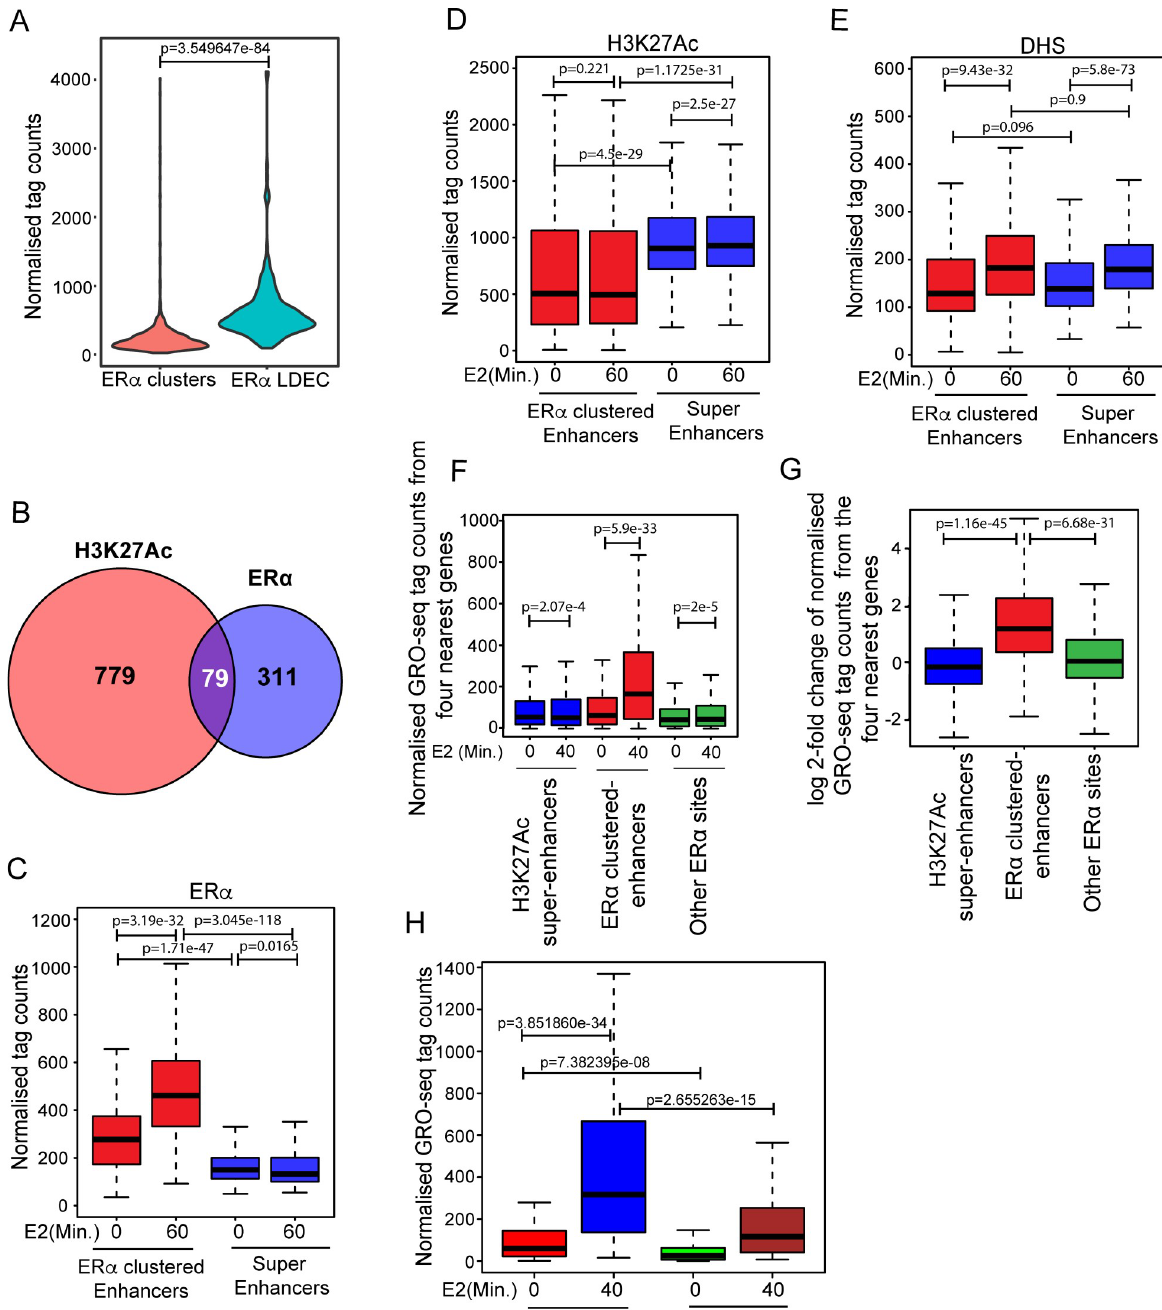
Fig 2. ER α super-enhancers but not conventional H3K27ac super-enhancers control E2 target genes. (A) Relative ER α tag counts on ER α clusters and LDECs. (B)Venn diagram showing overlap of 79, H3K27ac super-enhancers with ER α super-enhancers. (C-E) ER α binding strength (C), H3K27ac enrichment (D), and DHS signal (E) on H3K27ac super-enhancers and ER α super-enhancers in control and 60’ post-E2 treated cells show higher levels of ER α induction on ER α super-enhancers, higher H3K27ac enrichment on H3K27ac super-enhancers, but similar DHS induction in both categories of enhancers. (F) Expression of genes closer to H3K27ac super-enhancers and other ER α sites not in cluster do not change upon E2 treatment but the genes that are closer to ER α super-enhancers are highly induced upon E2 treatments. (G) Pre-E2 to post-E2 log2 fold changes in expression of genes closer to different categories of enhancers as mentioned in panel C. (H) Expression of E2-responsive genes closer to LDEC vs. other ER α sites. All p-values were calculated by either Wilcoxon rank sum test or Wilcoxon signed rank test. The boxplots depict the minimum, first quartile, median, third quartile and maximum without